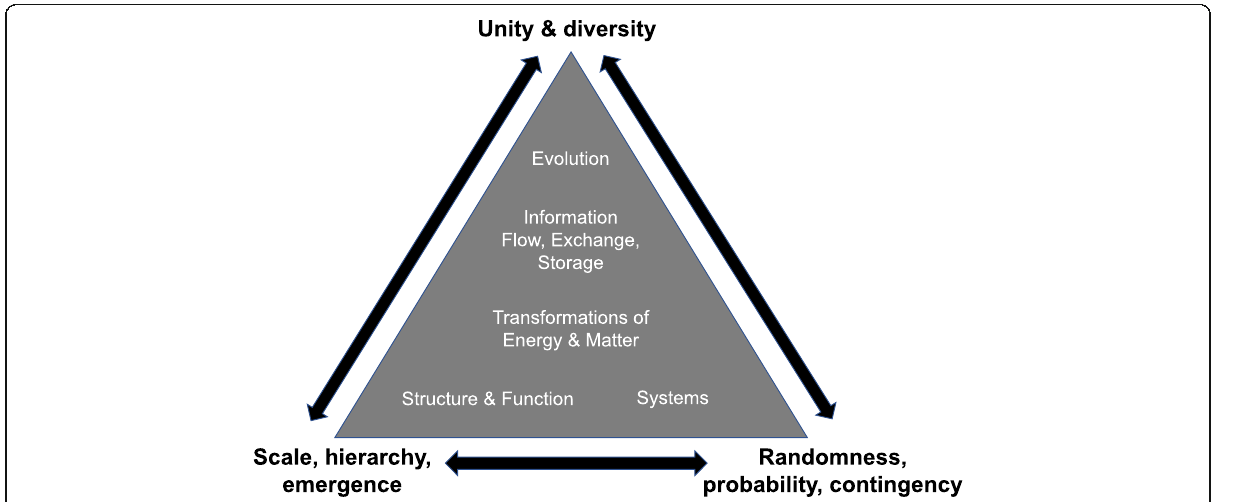
Fig. 3 Integrating conceptual frameworks into BER: student reasoning about unity and diversity; scale, hierarchy, and emergence; and randomness, probability, and historical contingency. Note that all three ideas interact to generate understanding about living systems, including processes within them (e.g., information